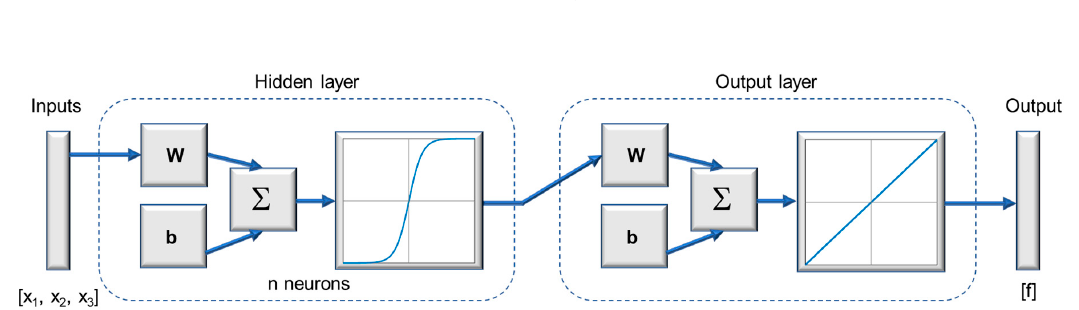
Figure 7. ANN with one hidden layer made of 𝑛 neurons.